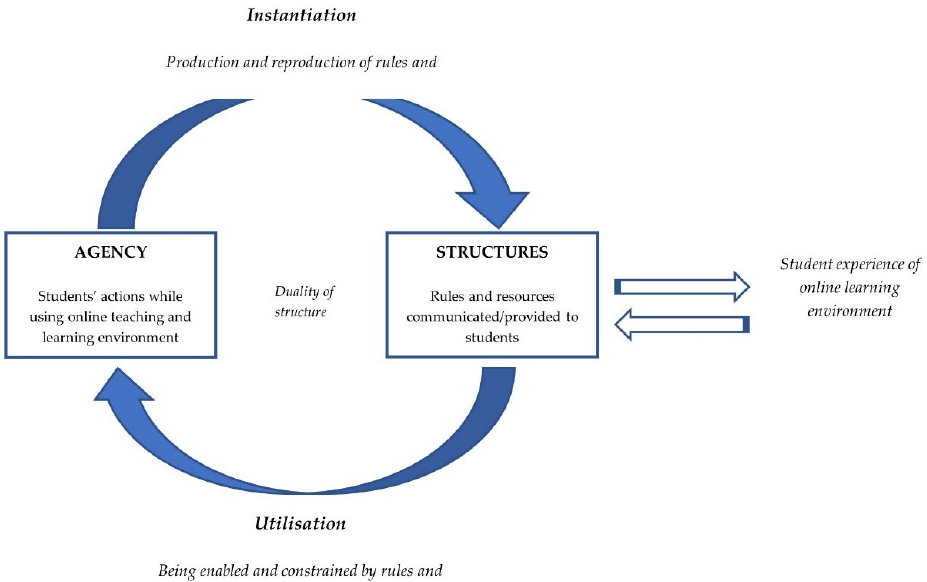
Figure 22. Application of structuration in the study, adapted from Groves et al. [44].